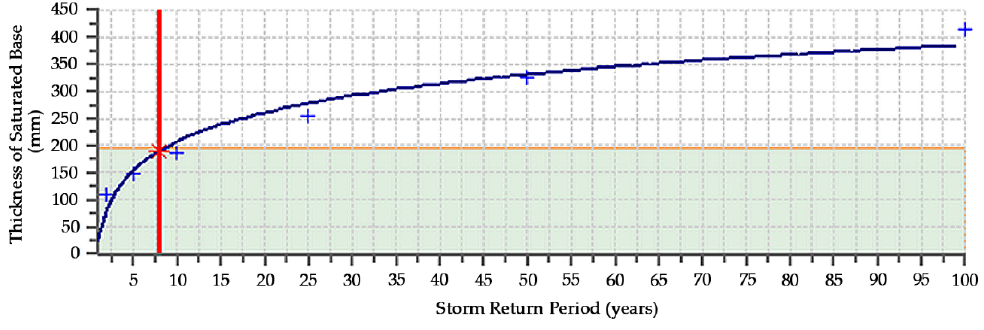
Figure 11. Thickness of saturated base (reservoir course) for the Technology Centre in